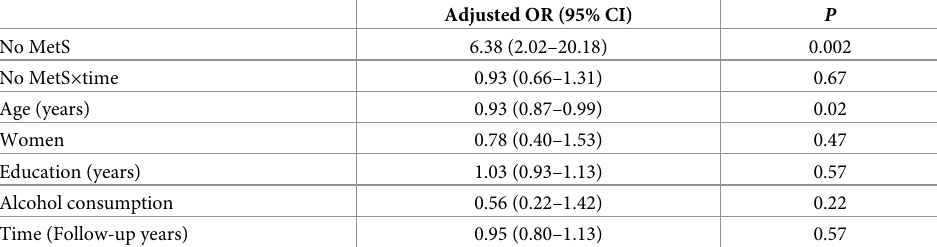
Table 4. Sensitivity analysis for the associations between MetS and successful aging over six years (n = 467) using the biomedical model of successful